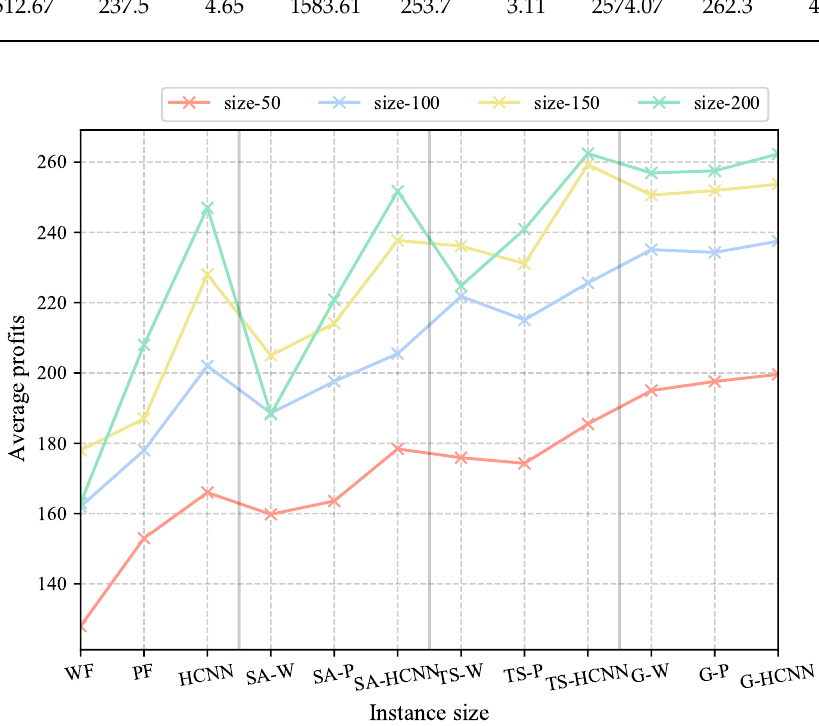
Figure 11. The average profit of total tasks of the comparison algorithms under different task